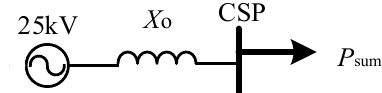
Figure 14. Simplified schematic diagram of VGS.